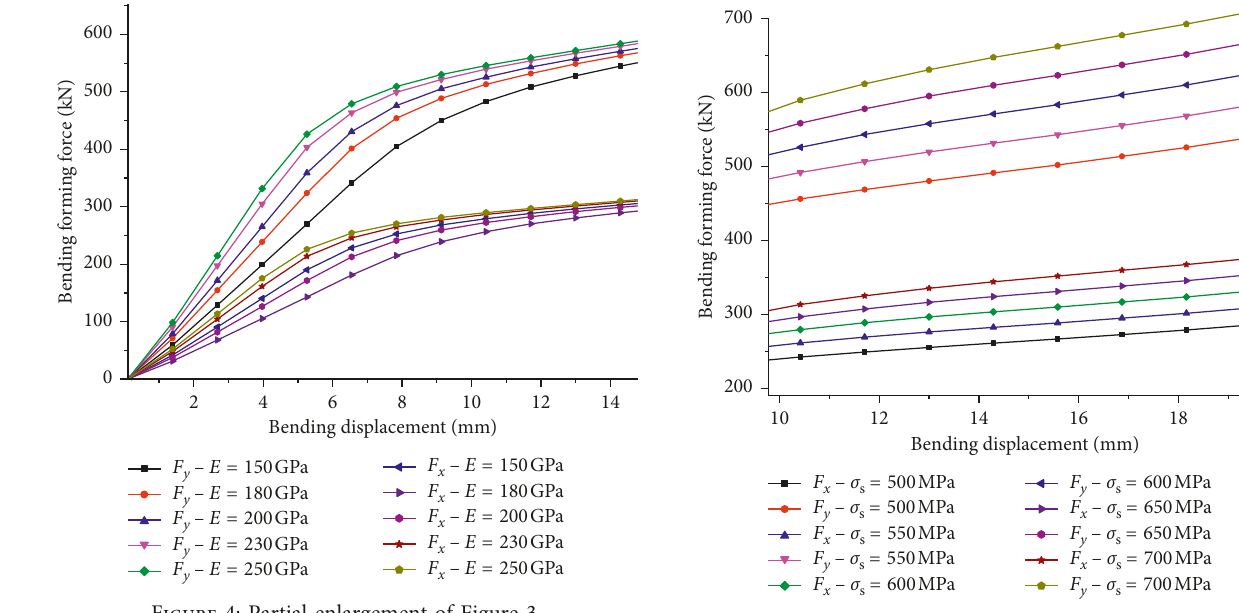
Figure 6: Partial enlargement of Figure 5.